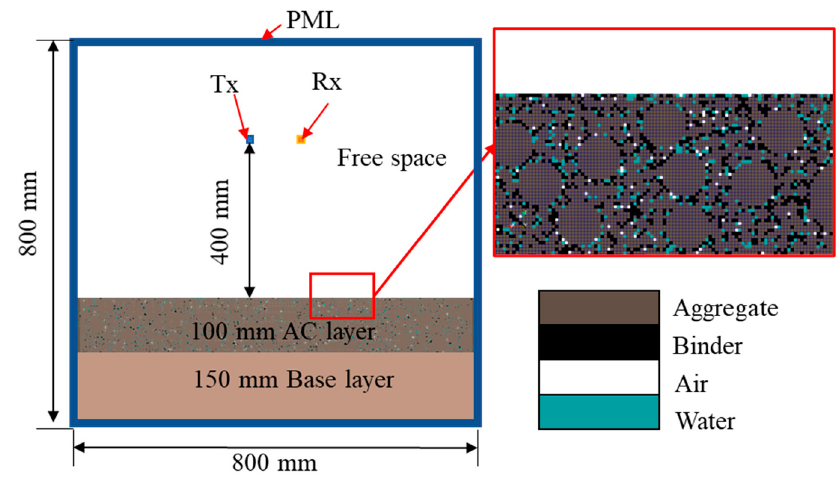
Figure 5. Diagram of an FDTD model in GprMax.